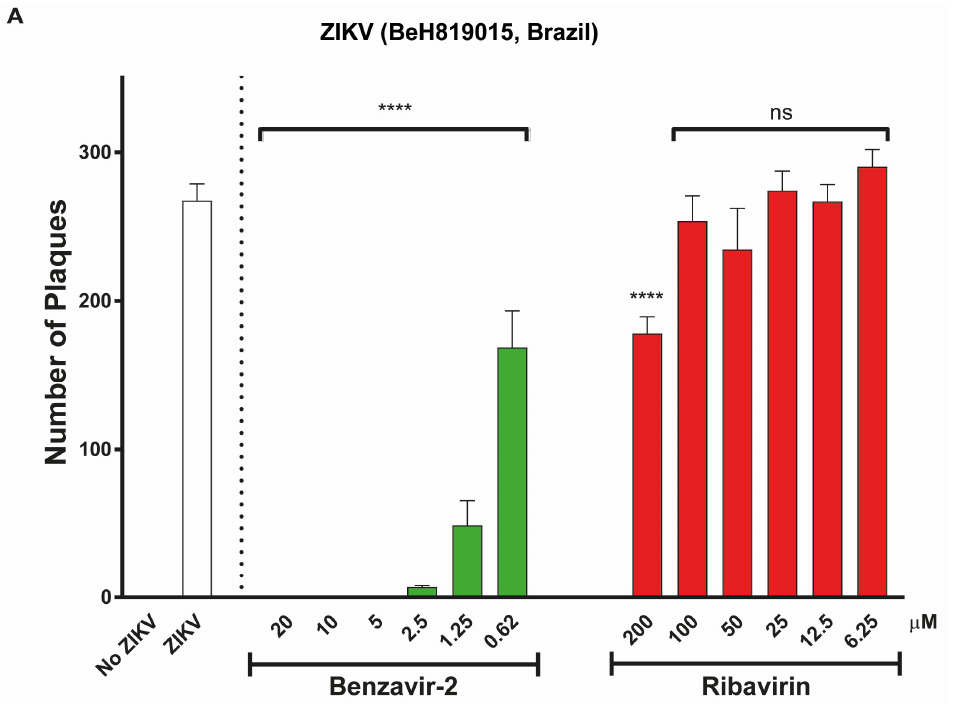
Figure 3. Antiviral activity of benzavir-2 and ribavirin against wild-type Zika virus (wt ZIKV) infection by plaque inhibition assay. Vero B4 cells were seeded in 12-well plates (2 × 10 5 cells per well) and viruses (300 PFUs), together with benzavir-2 or ribavirin in Dulbecco's modified Eagle medium (DMEM) with 1% carboxymethylcellulose (CMC), was added. The cells were incubated for 4 days. Next, cells were fixed with 4% paraformaldehyde and stained with 1% crystal violet solution. ( A ) Dose-dependent plaque-forming assay of the benzavir-2 effect against the Asian wt ZIKV lineage (BeH819015, Brazil strain). The assay was performed with 2-fold serial diluted benzavir-2 (from 20 to 0.62 µM) or 2-fold serial diluted ribavirin (200 to 6.25 µM). ( B ) Plaque forming assay at one benzavir- 2 concentration (2.5 µM) for two wt ZIKV lineages (Asian BeH819015, Brazil strain and the African lineage MR766, Uganda strain). The results were visualized after crystal violet staining. ( C ). Quantification of the number of plaques in B. For all experiments, quantification data were analyzed